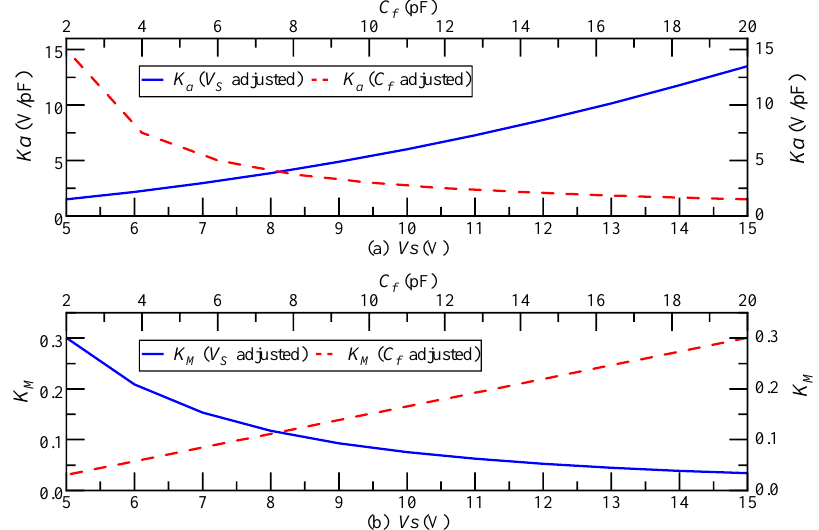
Figure 10. ( a ) The changing trend of K a when V s and C f are adjusted; ( b ) the changing trend of K M when V s and C f are adjusted.